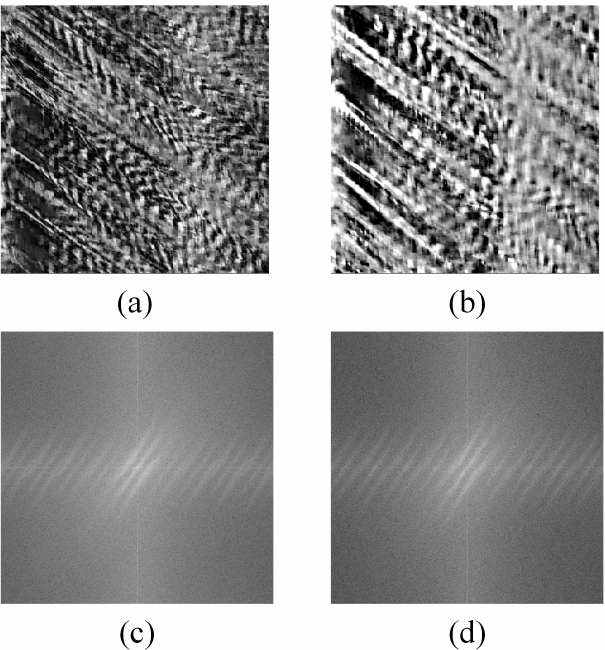
Figure 9. MSR image enhancement before and after comparison: ( a ) before STI enhancement, ( b ) after STI enhancement, ( c ) the frequency-domain image before enhancement, ( d ) the frequency-domain image after